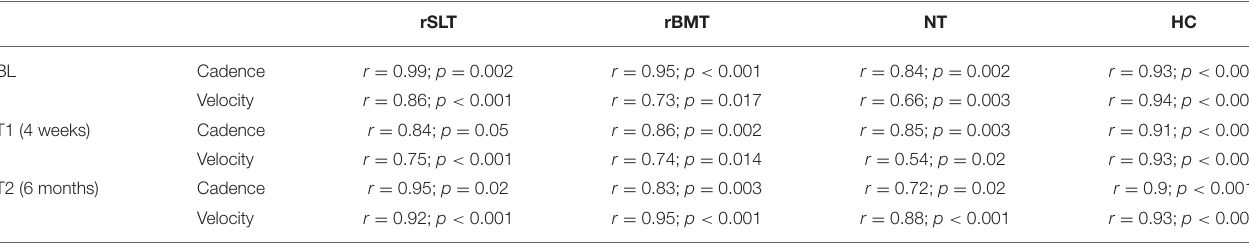
TABLE 4 | Correlations between speech and gait across groups and